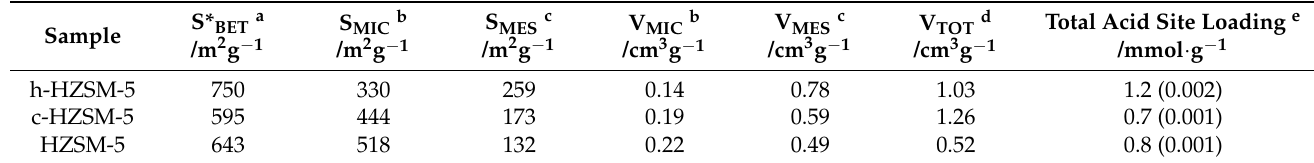
Table 2. Textural properties of calcined zeolite ZSM-5 materials.